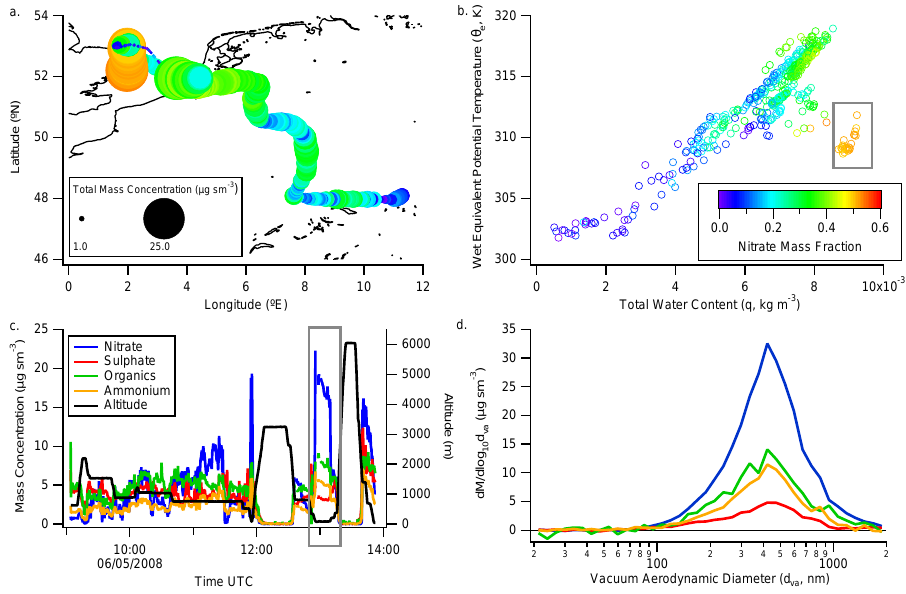
Fig. 4. Case study example of the vertical mixing of atmospheric aerosol during flight B362. Panel (a) displays the aircraft’s flight track coloured according to the nitrate mass fraction, while the markers are sized according to the AMS total mass concentration. Panel (b) shows the relationship between the wet equivalent potential temperature, θ e , and the total water content, q . The relationship is coloured according to the nitrate mass fraction, while the grey box indicates the data corresponding to SLR-8 during B362. Panel (c) shows the AMS mass concentration time series and the altitude of the aircraft during the flight. Panel (d) shows the mass-size distribution from the AMS for